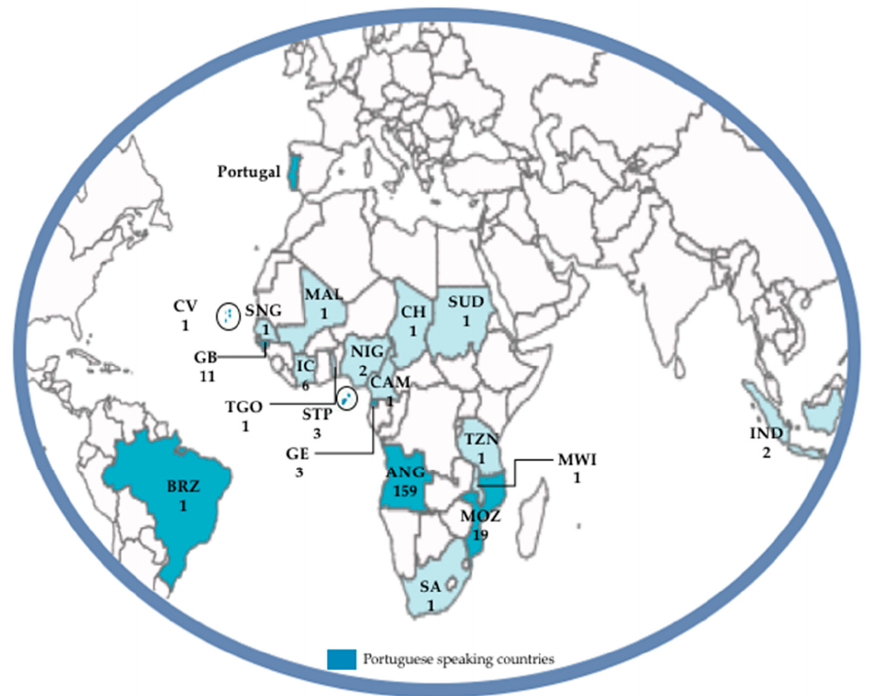
Figure 1. Geographical distribution of imported malaria cases. Parasite isolates’ country of origin is marked in blue. ANG, Angola; BRZ, Brazil; CV, Cape Verde; CH, Chad; CAM, Cameroon; GE, Equatorial Guinea; GB, Guinea Bissau; IND, Indonesia; IC, Côte D’Ivoire; MWI, Malawi; MAL, Mali; MOZ, Mozambique; NIG, Nigeria; STP, São Tomé and Príncipe; SNG, Senegal; SA, South Africa; SUD, Sudan; TZN, Tanzania; TGO, Togo.